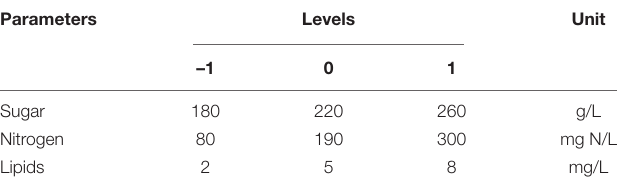
TABLE 1 | Concentrations of the studied parameters.